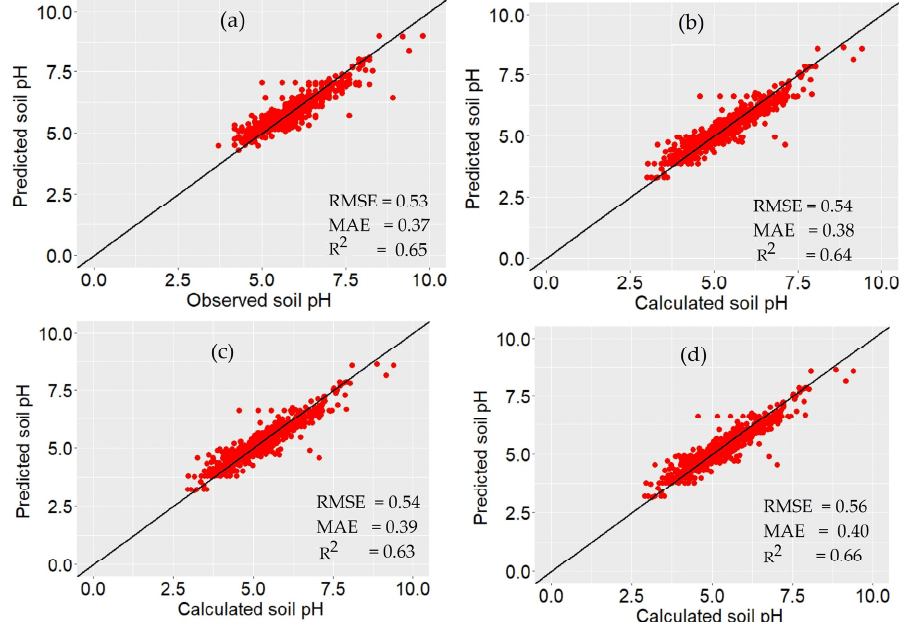
Figure 9. Density scatter plots of predicted against observed soil pH using ensemble machine learning: cross-validation results for soil pH in ( a ) 1980, ( b ) 2022, ( c ) 2050 in the BAU scenario, and ( d ), 2050 in the EqD scenario. The black line is the 1:1 line. MAE: mean absolute error; RMSE: root mean square error; R 2 : coefficient of determination. For S1, S2, and S3, see the cross-validation results in Table S5.